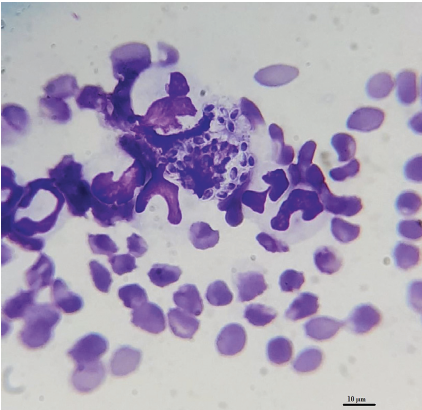
Figure 1: Amastigote of Leishmania ssp. in blood smears stained with Giemsa, 100